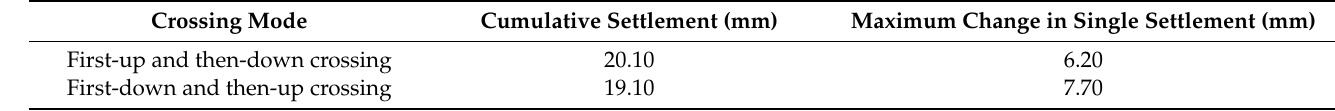
Table 2. Comparison of surface displacement under different crossing sequences.